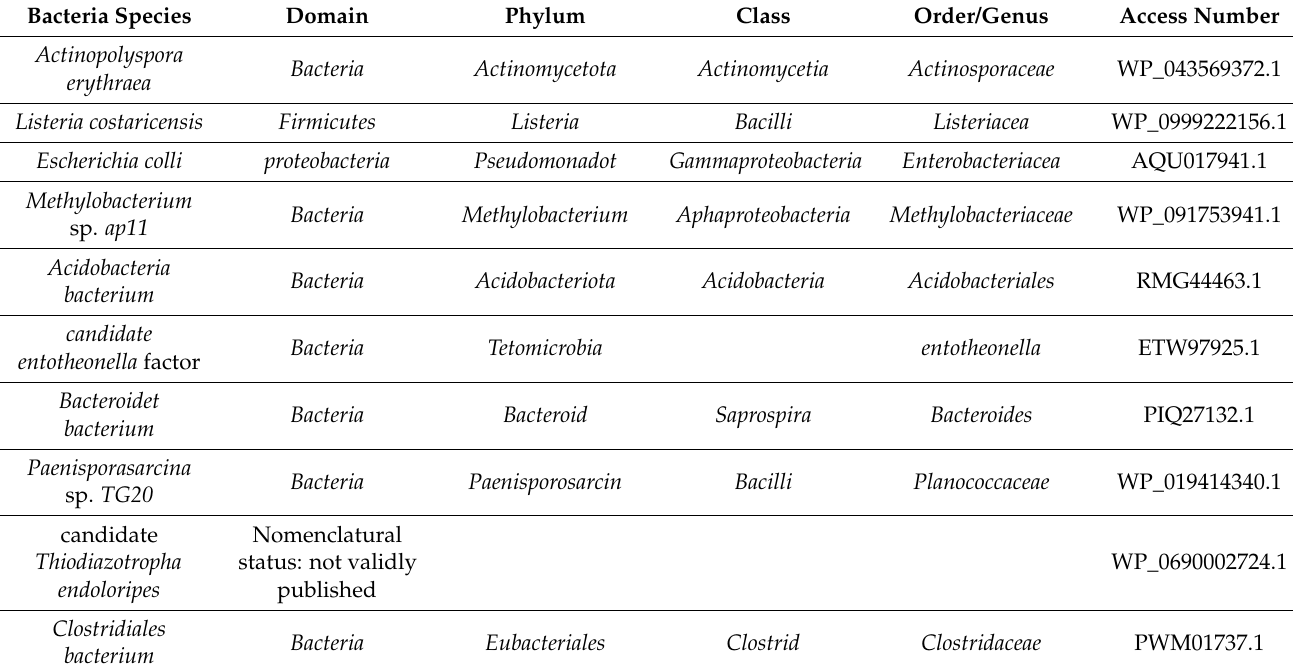
Table 4. Proteins for which emPAI was significantly higher in the study group compared to the control group.